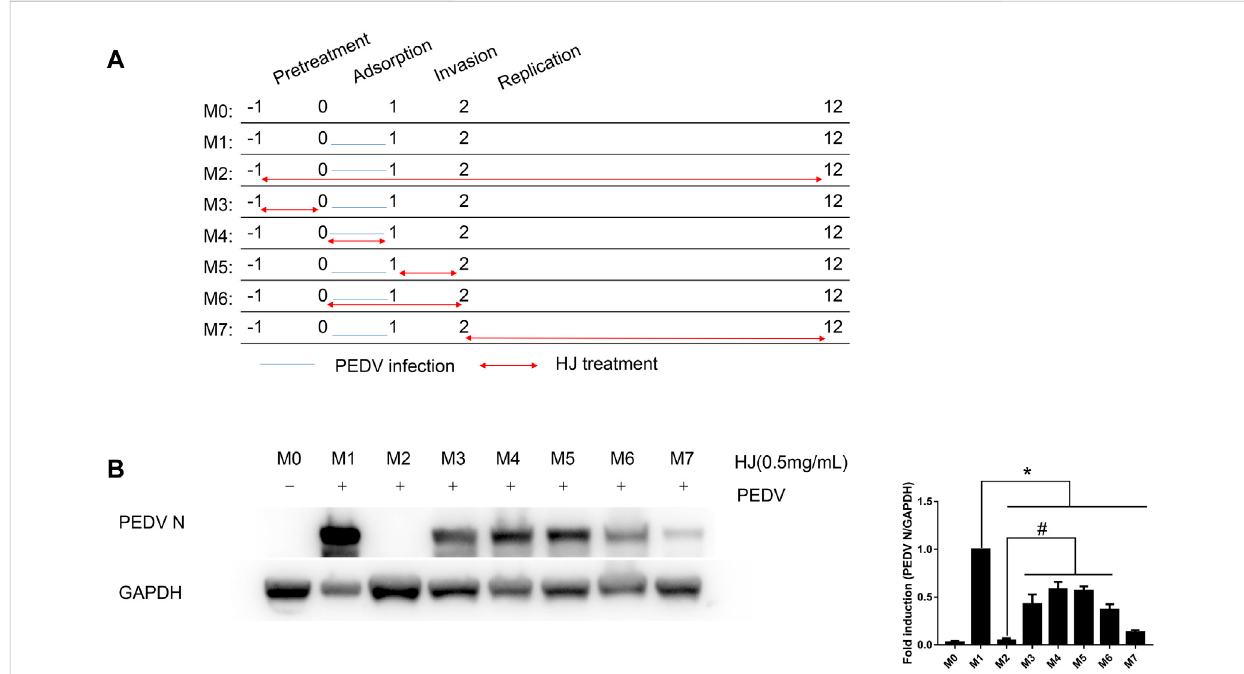
FIGURE 5 Inhibitory effects of HJ on IPI-FX cells infected with PEDV virus at different stages. (A) IPI-FX cells were treated with HJ at different times before or after infection. Double-headed red arrows indicate the presence of HJ, while the orange horizontal lines indicate the time of PEDV infection. The experiments are identi fi ed in the text by the numbers on the left (M0 – M7). (B) The expression level of PEDV N protein in IPI-FX cells was examined by western blot assays. Cells were harvested for 12 h. The expression level of PEDV N protein was calculated in relation to the expression level of GAPDH. Results are representative of three independent experiments. Data are represented as mean ± SD, n = 3. *, and p < 0.05 was considered statistically signi fi cant compared with M1, while # , and p < 0.05 was considered statistically signi fi cant compared with M2.